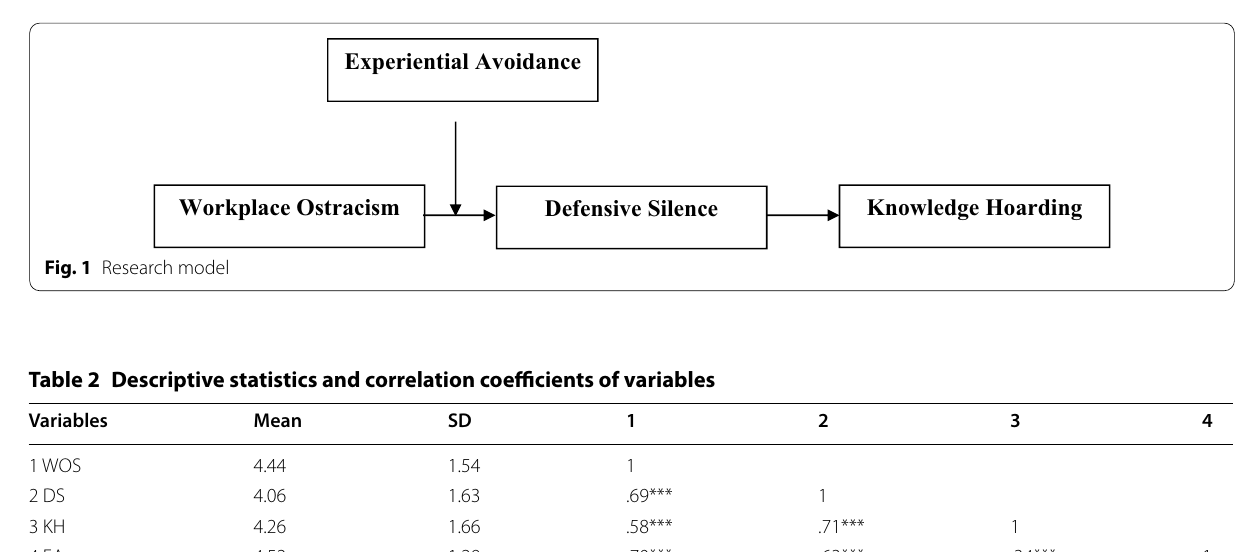
WOS workplace ostracism, DS defensive silence, KH knowledge hoarding, EA experiential avoidance, * p < .05, ** p < .01, *** p < .001, n